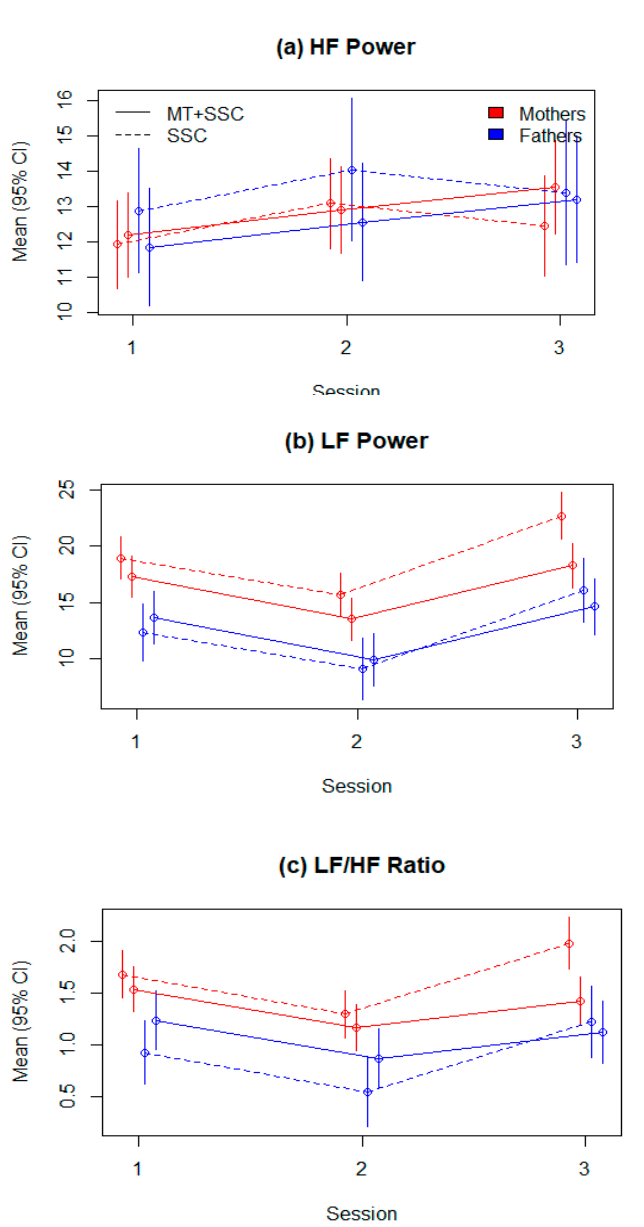
Figure 2. HRV parameters across all three sessions. ( a ): HF; ( b ): LF; ( c ): LF/HF ratio. Table 5. Linear mixed effects models of secondary HRV outcomes across all three sessions.